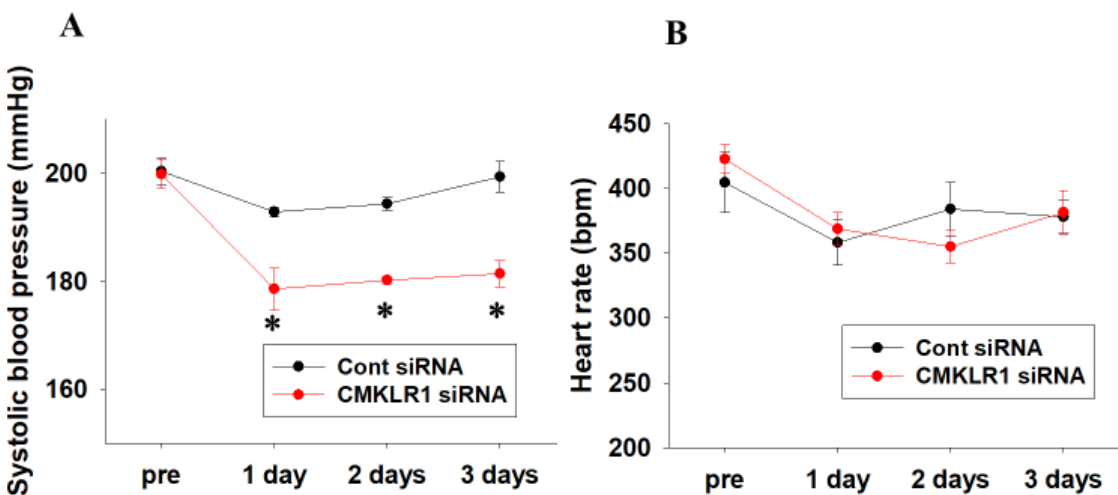
Figure 3. Short-term effects of CMKLR1 siRNA on systolic blood pressure and heart rate in SHR. Cont siRNA (0.04 nmol/head, i.c.v.) or CMKLR1 siRNA (0.04 nmol/head, i.c.v.) was administered to male SHR for 3 days. Systolic blood pressure ( A ) and heart rate ( B ) were measured by tail cuff system. Data were shown as mean ± SEM (Cont siRNA; n = 4, CMKLR1 siRNA; n = 5). Pre: before administration of siRNA. 1–3 days: 1–3 days after administration of siRNA. * p < 0.05 vs. Cont siRNA.